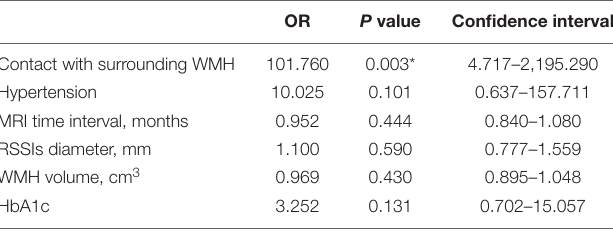
TABLE 3 | Multivariate logistic regression analysis of cavitation of subcortical white matter RSSIs. OR P value Confidence interval